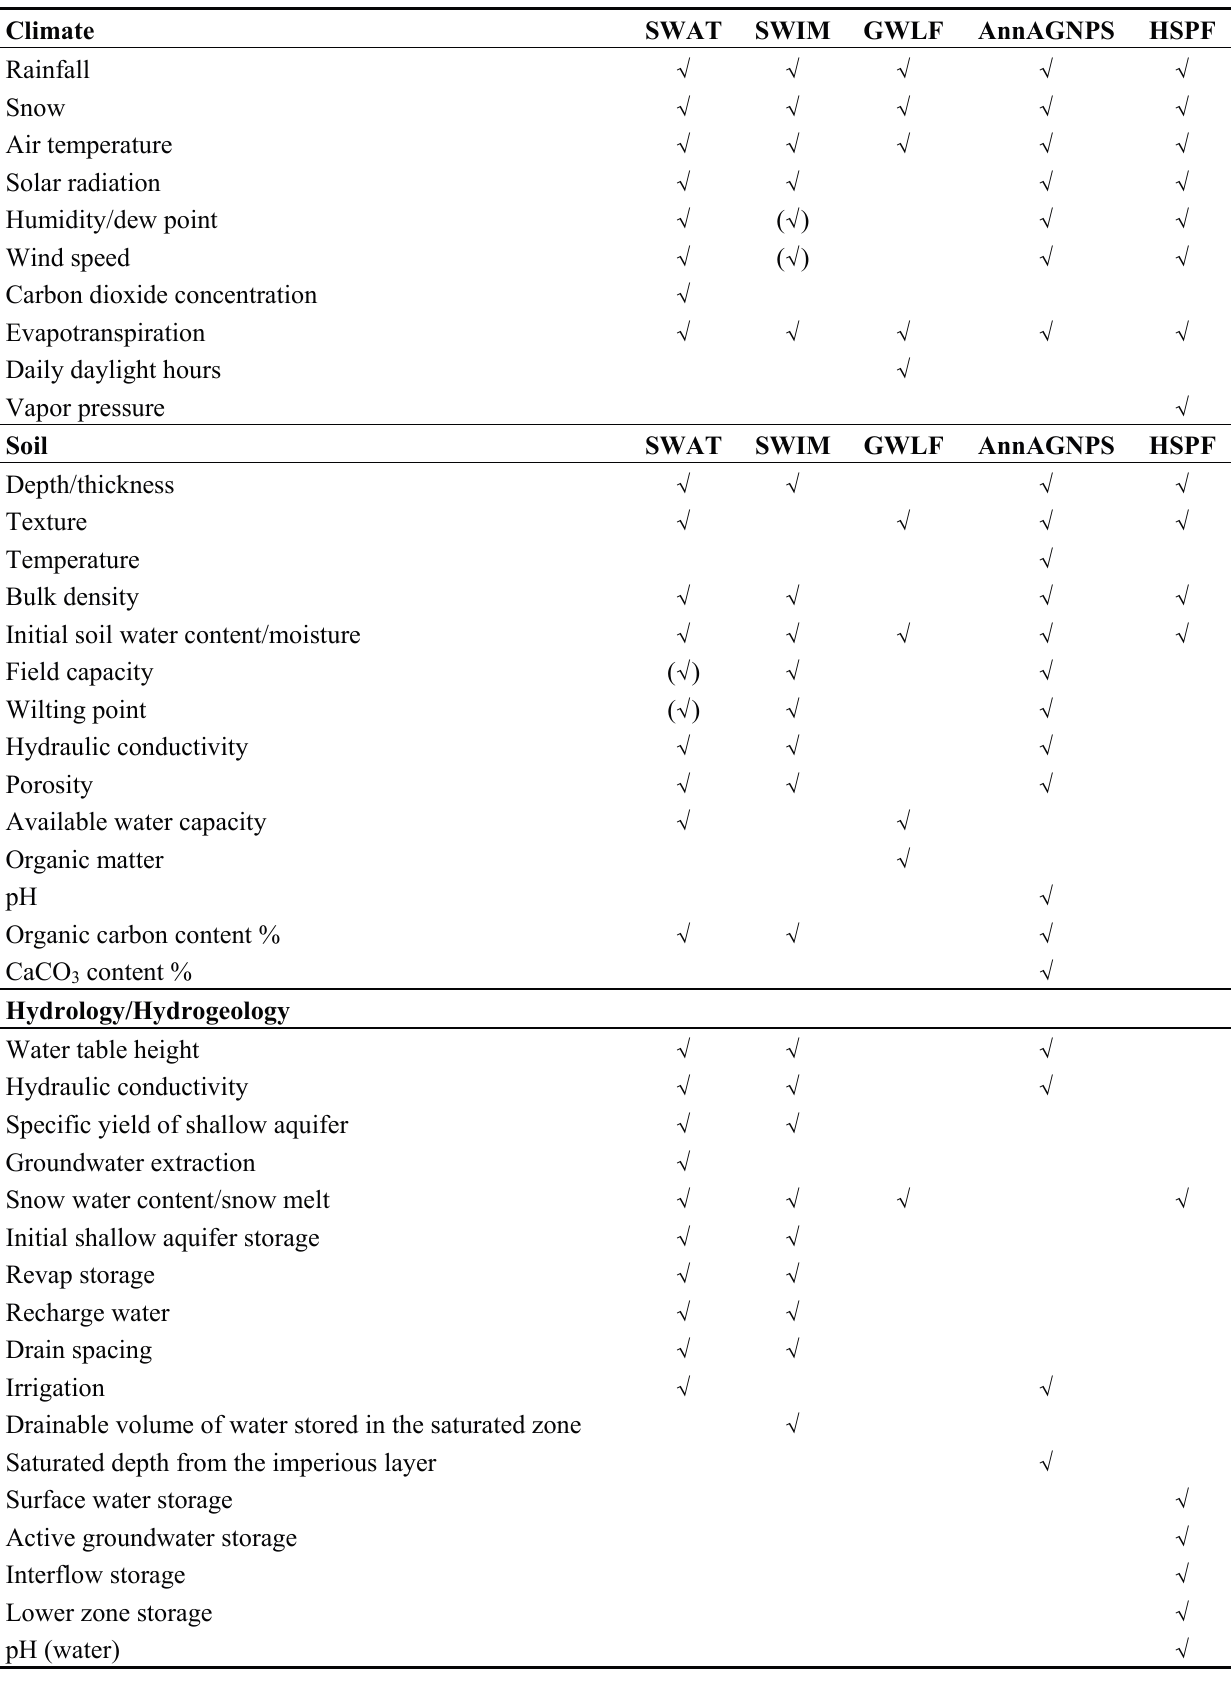
Table 2. Basic input requirements of the five models (“( √ )” means this input can be either supplied by measurements, or calculated by the